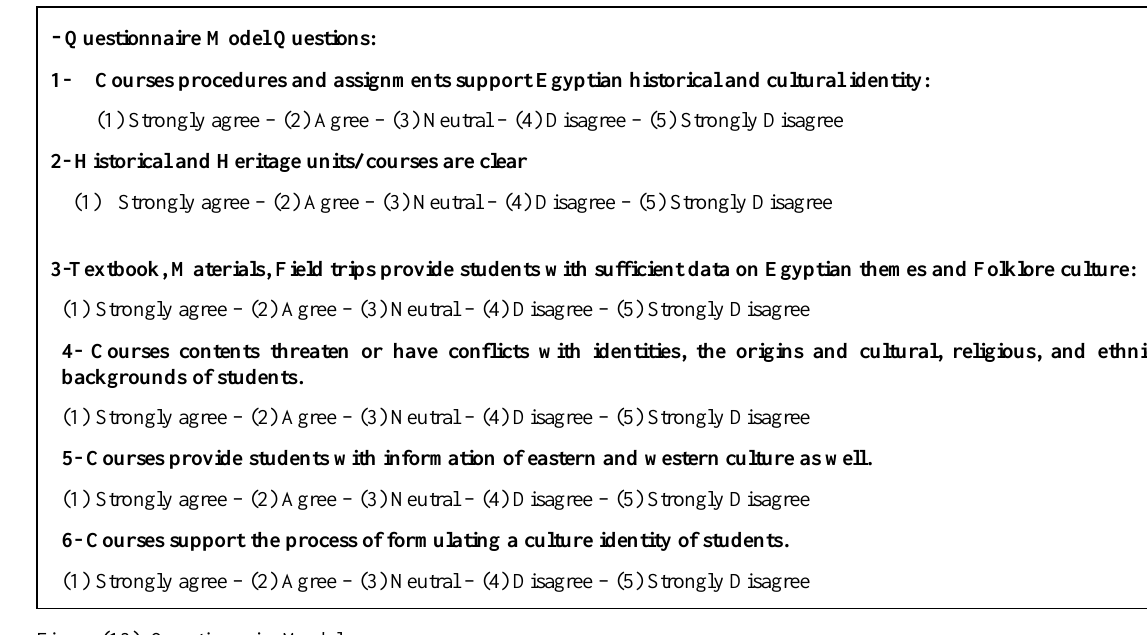
Figure (13): Questionnaire Model Source: Done by the